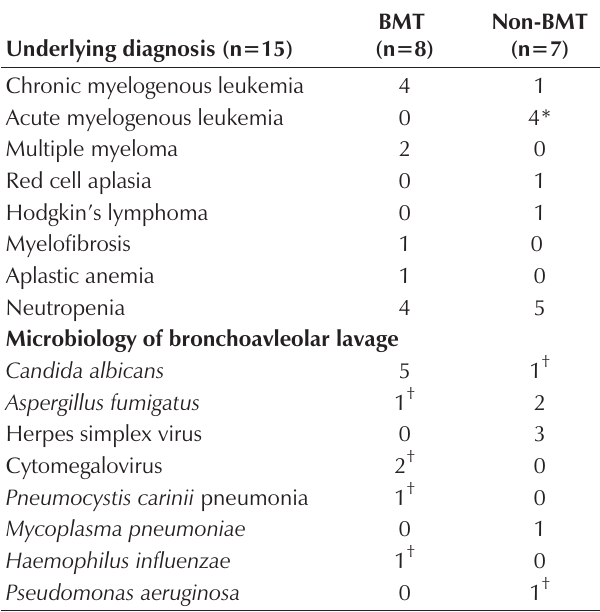
Characteristics of patients who died during hospital